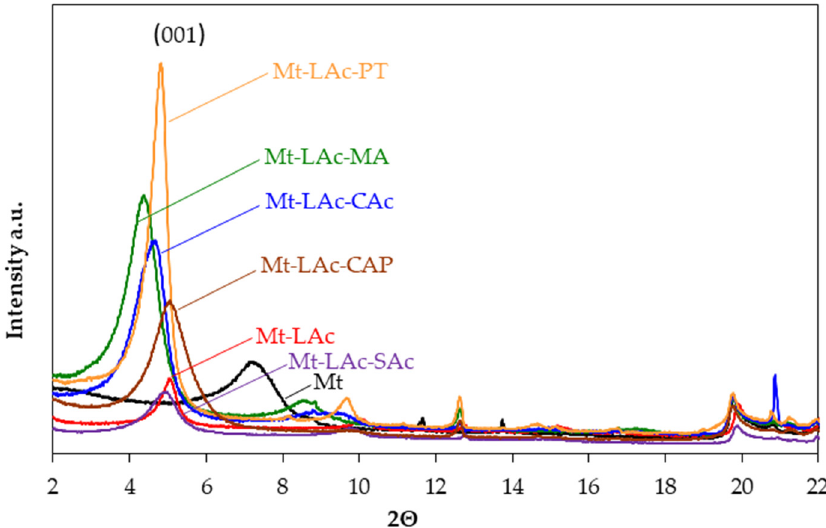
Figure 2. XRD diffractogram of sodium Mt and organophilic montmorillonites.